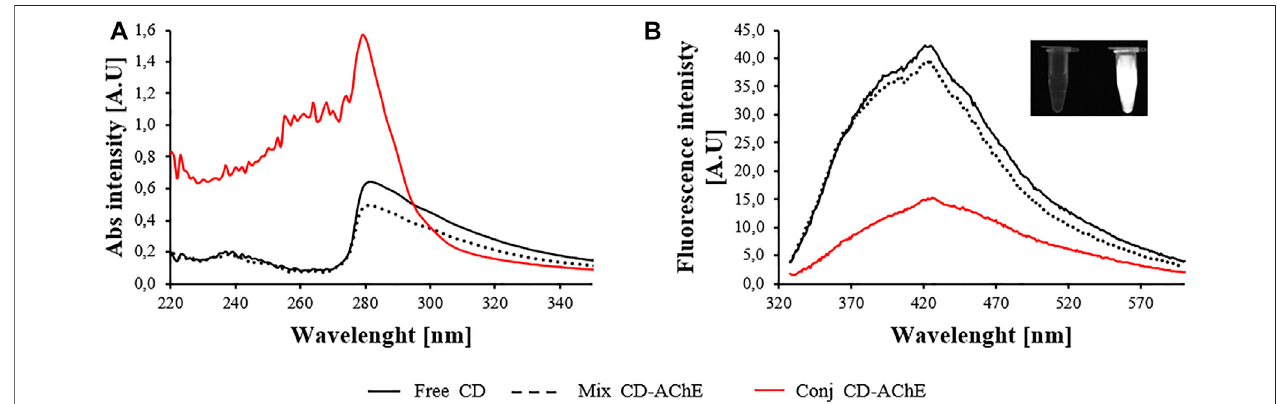
FIGURE 2 | (A) UV-Vis spectrum showing the increase in the peak at 280 nm for the conjugated carbon dot (CD) and AChE at 5 U mL − 1 , due to amide bond formation. (B) Fluorescence emission spectrum (excitation at 320 nm) showing the decreasing fl uorescence ofthe CDfor the conjugation ofCD and AChEat 5 U mL − 1 . The inset in (B) shows the CD under UV light and the mili Q water